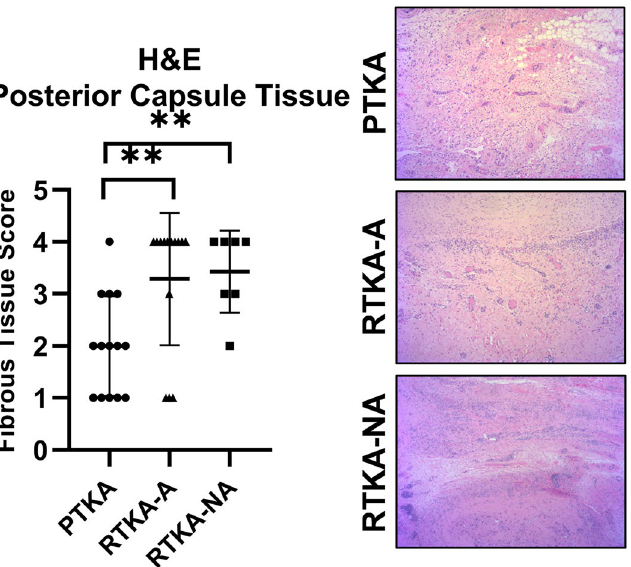
Figure 2. Histopathologic assessment of fibrosis in the periarticular knee tissue. Histopathologic fibrotic scores of H&E-stained sections for the periarticular tissue and representative images from the three patient groups ( PTKA = primary TKA, RTKA-A = arthrofibrosis, RTKA-NA = non-arthrofibrosis). The graphs depict mean fibrous tissue score ± standard deviation, with each data point representing one patient. Asterisk denotes a significant difference, (**p ≤ 0.01), by the Wilcoxon Rank Sum test. All images were taken using the 10X objective on a Nikon E600 bright-field light microscope.